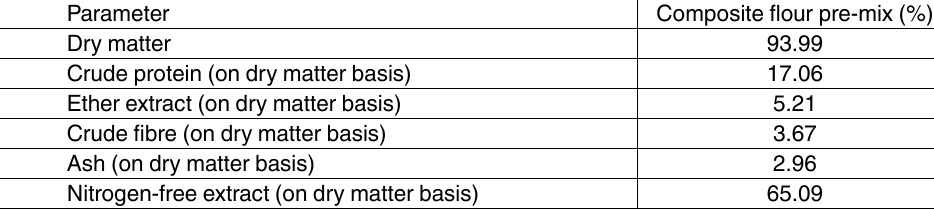
table 2. Proximate analysis of the composite flour pre-mix